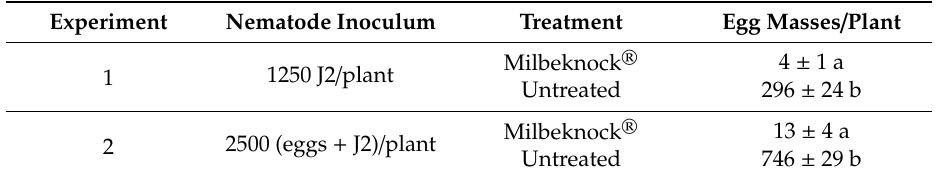
Table 1. E ff ect of Milbeknock ® on root infection by Meloidogyne javanica on tomato ‘Roma’ in pot experiments 47 days after